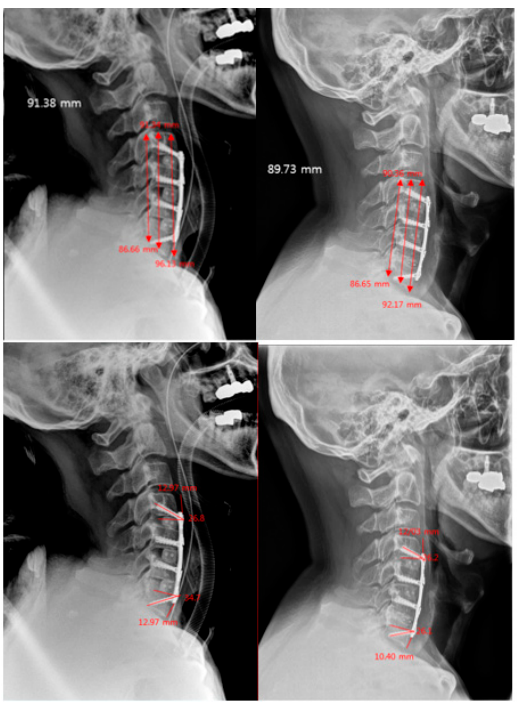
Figure 2. Short plate–high-angled screw technique, 3 level fusion. Images on the left show the immediate post-operative X-rays; the right show the X-rays performed at the 1-year follow-up. Comparing the images, it shows minimal subsidence and change in PPD and screw angles at 1 year.